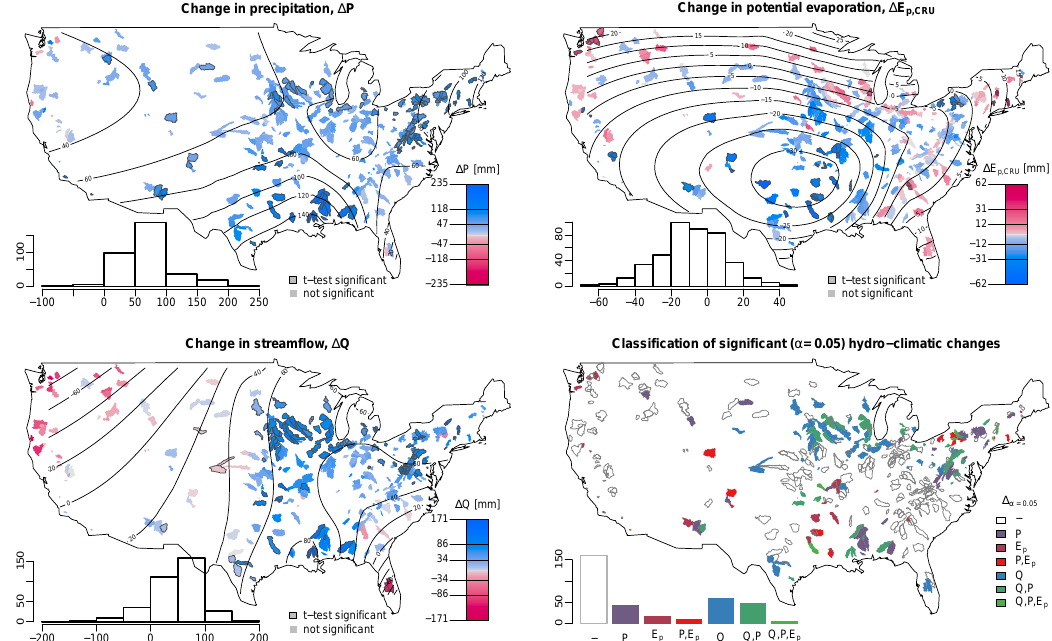
Fig. 4. Maps of absolute change in hydro-climatic variables of the MOPEX dataset, comparing changes between the periods 1949–1970 and 1971–2003. Annual changes are given in millimeter. Significant changes in the mean of both periods are tested by univariate two-sample t-tests with α = 0 . 05 and are denoted by a grey borderline. For each variable, a histogram of the changes is given in the lower left corner. The map in panel (d) provides a classification based on the univariate t-tests. Table 2. Pearson correlation coefficients for the average change between the two periods, assessed for all basins with data available. Sig- nificance of correlation is denoted with letters ( a 0.001, b 0.01, c 0.05), with significant correlations ( α < 0 . 05) set in bold for visual